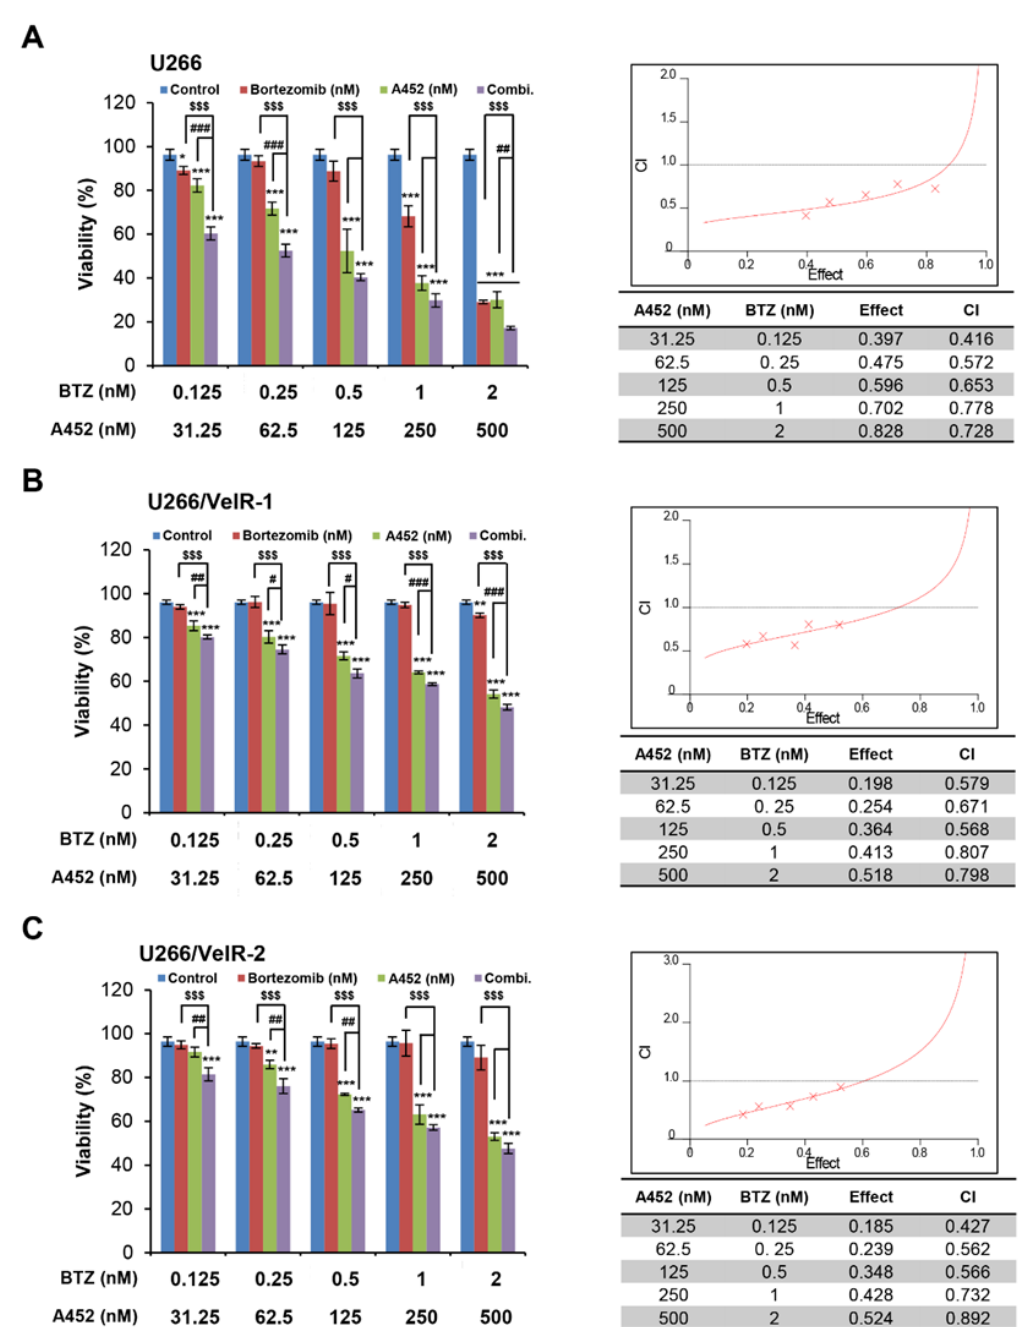
Figure 3. Cotreatment with A452 and BTZ triggers synergistic cytotoxicity in both BTZ-sensitive and BTZ-resistant U266 MM cells. ( A ) BTZ-sensitive U266 and ( B , C ) BTZ-resistant U266 (U266/VelR-1 and U266/VelR-2) MM cells were treated with 0.1% DMSO (control), A452, and BTZ or in combination with these compounds as indicated for 72 h. Combination treatments were performed in U266 ( A ) and BTZ-resistant U266 ( B , C ) cells maintaining a constant ratio between the dose of the A452 and BTZ, and cell viability were assessed at 72 h by CCK-8 assay. The combination index (CI) value and the relative fraction affected (FA) were determined at each dose combination (actual), and a simulation was run to estimate the CI value and confidence interval (—) across the entire FA range (simulation). CI < 1, CI = 1, and CI > 1 indicate synergistic, additive, and antagonistic effects, respectively. CI was calculated by the CalcuSyn software program. Data present as mean ± SD ( n = 3). * p < 0.05, ** p < 0.01, and *** p < 0.001 vs. DMSO control, $$$ p < 0.001 vs. BTZ-treated group, # p < 0.05, ## p < 0.01, and ### p < 0.001 vs. A452-treated group; two-way analysis of variance (ANOVA) test.